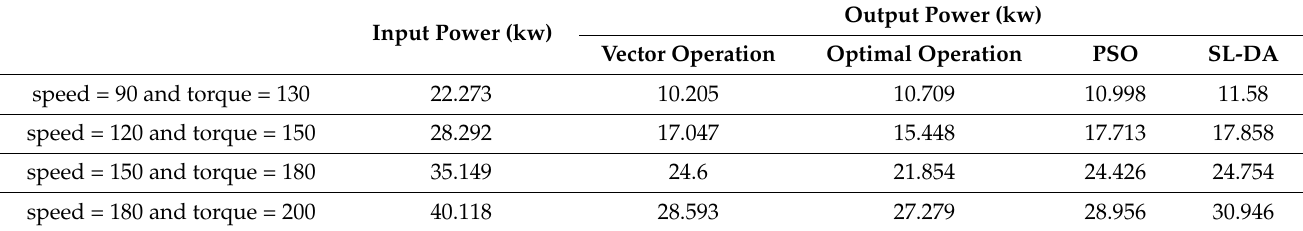
Table 4. Output power analysis of proposed work over state-of-the-art models.